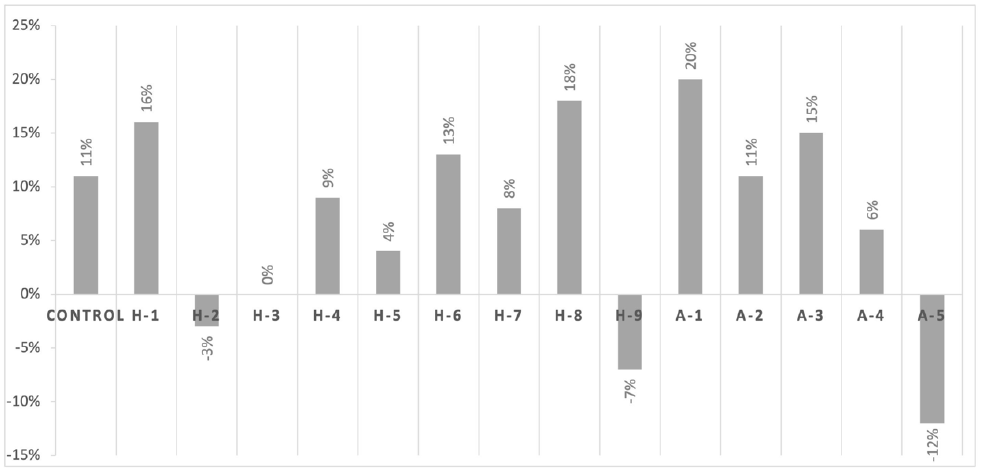
Figure 3. Percentage increase or decrease in the diameter of the inhibition zone when icariin is used in combination with ampicillin in comparison with the control strain. Complete descriptions of the abbreviated strain names on the x -axis can be found in Table 1.